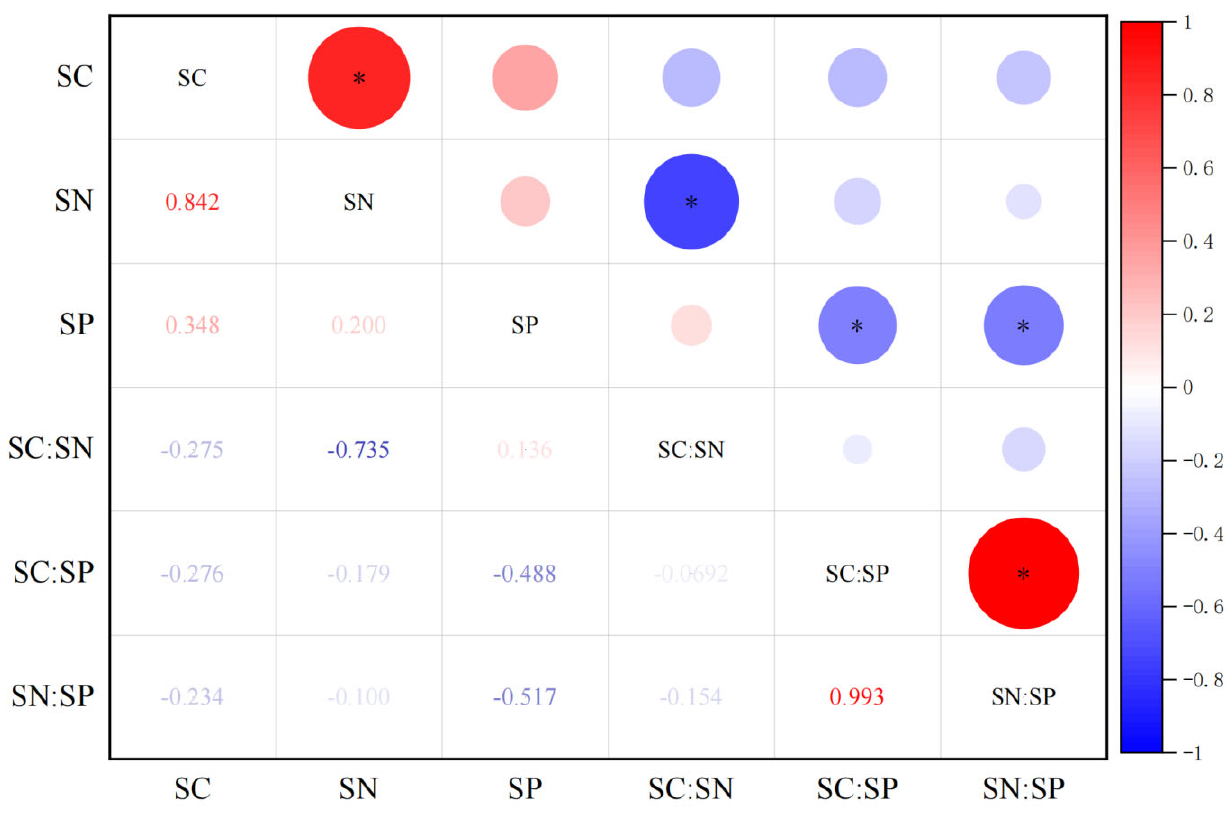
Figure 5. Correlation of SC, SN, and SP contents and stoichiometric characteristics of Moso bamboo expansion into Chinese fir forests (* represent significance levels of p < 0.05).